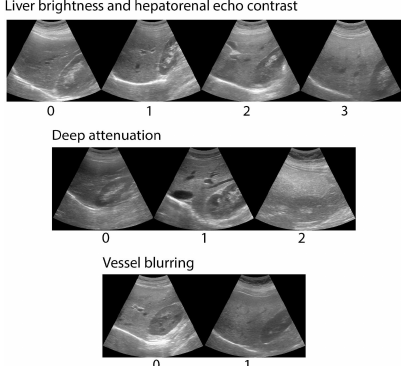
Figure 1. Examples of abdominal ultrasound images combined with the semi-quantitative score system by Hamaguchi et al. to assess liver fat infiltration in Chilean young adults . The system scores liver brightness from 0 to 3, diaphragm attenuation from 0 to 2 and vessel blurring from 0 to 1. Maximum score possible was 6.